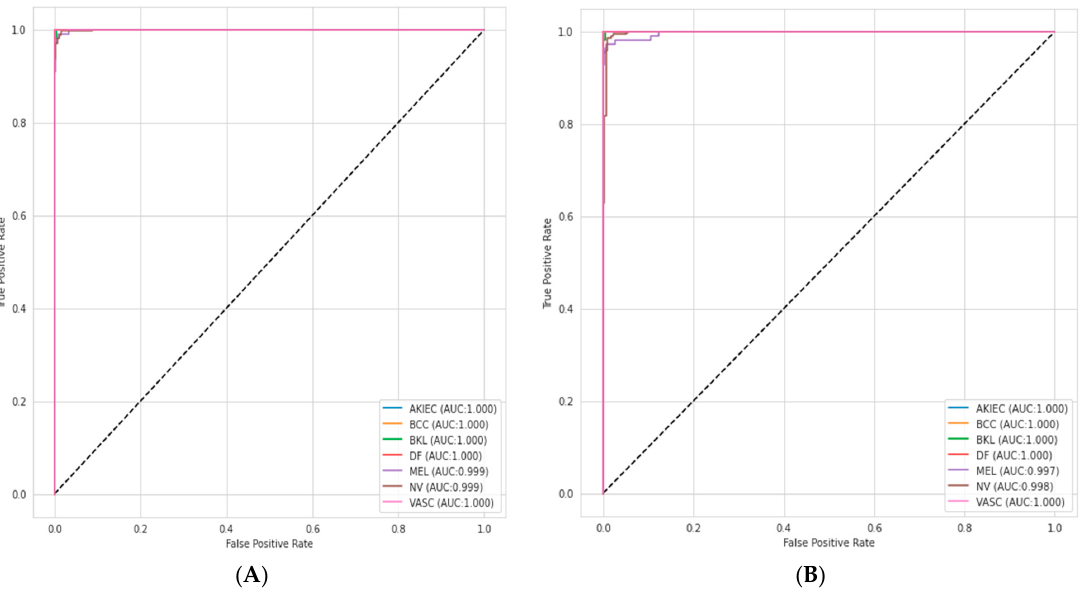
Figure 9. ROC–AUC scores of ( A ) the ensemble model and ( B ) the EfficientNetV2S model.